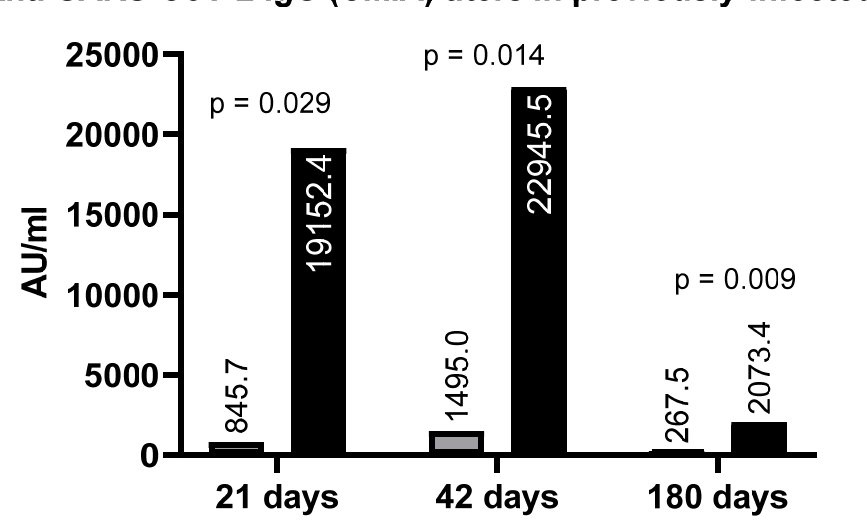
Figure 2. Difference in RBD-specific IgG antibodies in potentially previously infected individuals based on SARS-CoV-2 nucleoprotein detection who were immunized with Sputnik-V vaccine versus those who were SARS-CoV-2 nucleoprotein negative, taken as previously